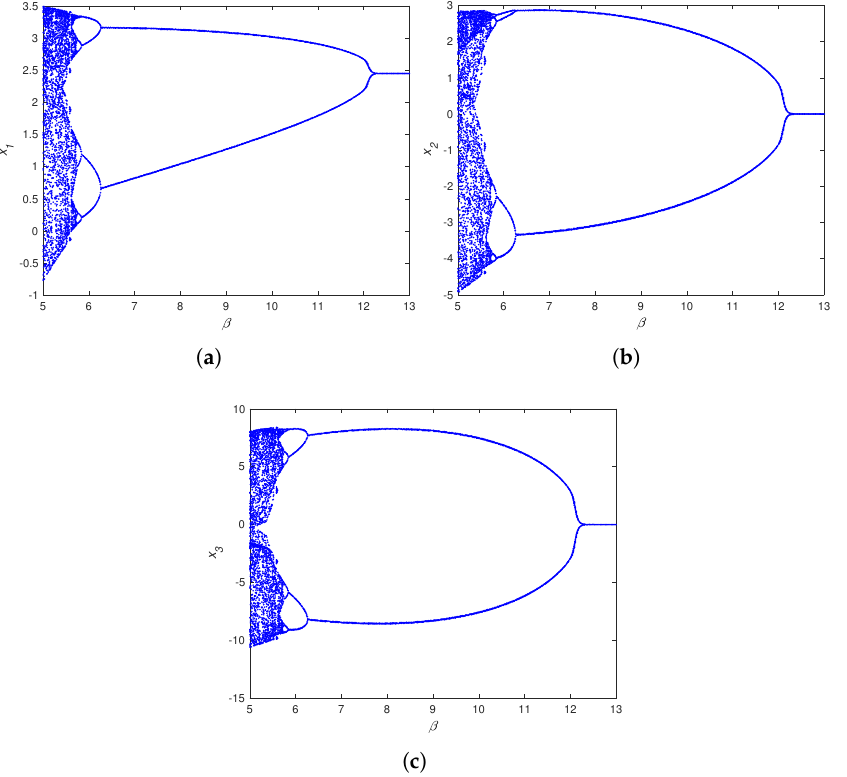
Figure 5. Bifurcation Diagram: ( a ) local maxima of x 1 vs. Control Parameter β , ( b ) local maxima of x 2 vs. Control Parameter β , ( c ) local maxima of x 3 vs. Control Parameter β